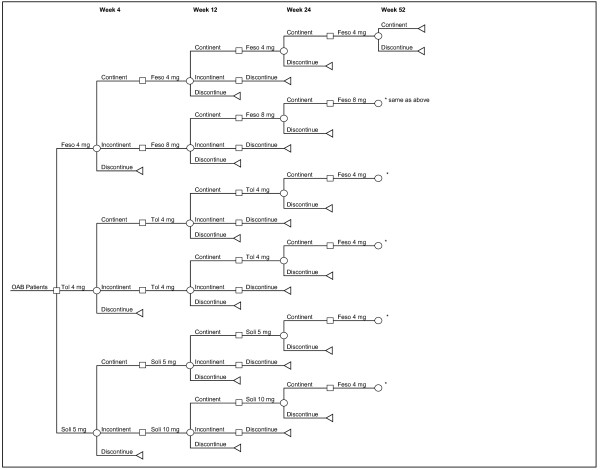
Decision tree model.